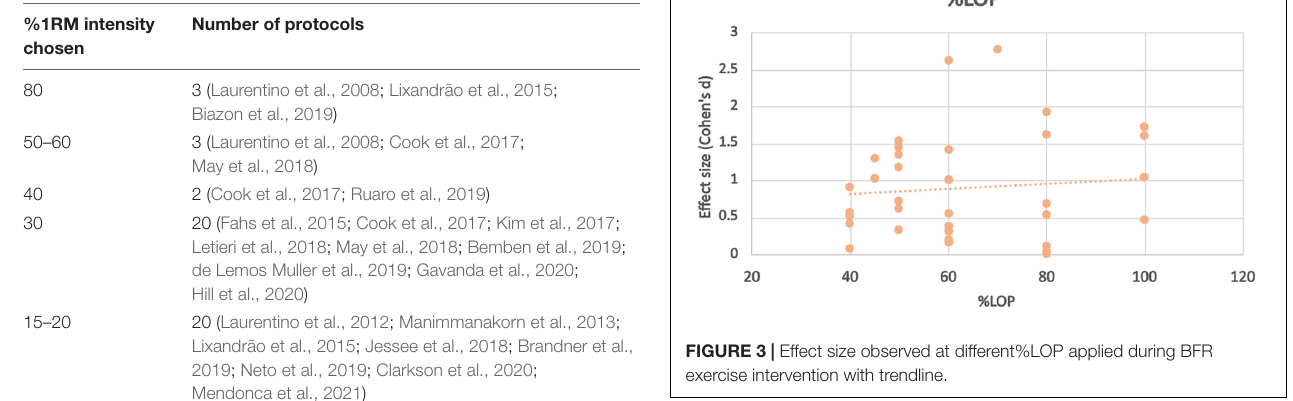
TABLE 2 | Distribution of %1RM intensity for BFR training across the 48 protocols.